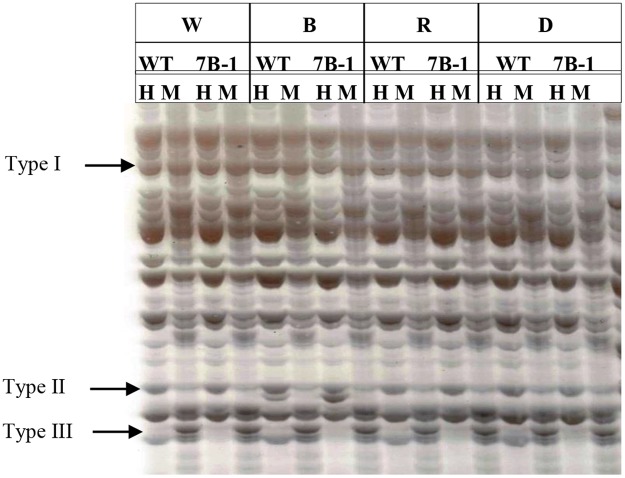
A representative MSAP gel using E2/H4 primer combination. W, B, R, and D correspond to white, blue, and red lights and dark, respectively.Letters H and M show EcoRI/HpaII and EcoRI/MspI enzymes combinations, respectively. Type I, II and III methylation profiles are indicated by arrows.